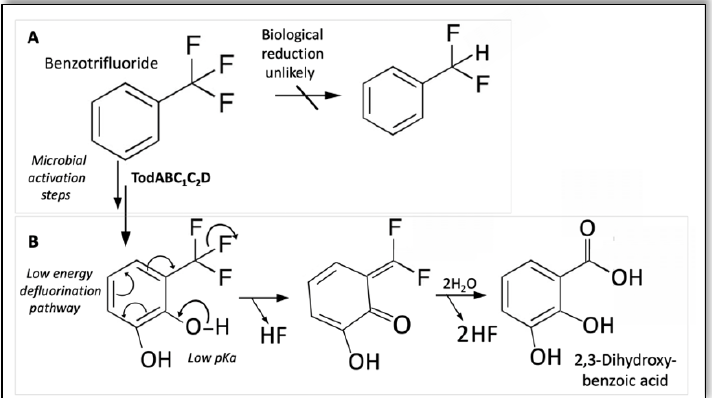
Figure 4. Metabolic activation of benzotrifluoride leading to complete defluorination of the trifluoromethyl group. ( A ) The direct cleavage of the C – F bond by a reductive mechanism is unlikely. ( B ) Dihydroxylation of the ring produces a phenolate anion at neutral pH that undergoes ring electron rearrangement that displaces one HF equivalent and produces an ortho -quinone methide. The latter may then undergo facile hydrolysis and complete defluorination.